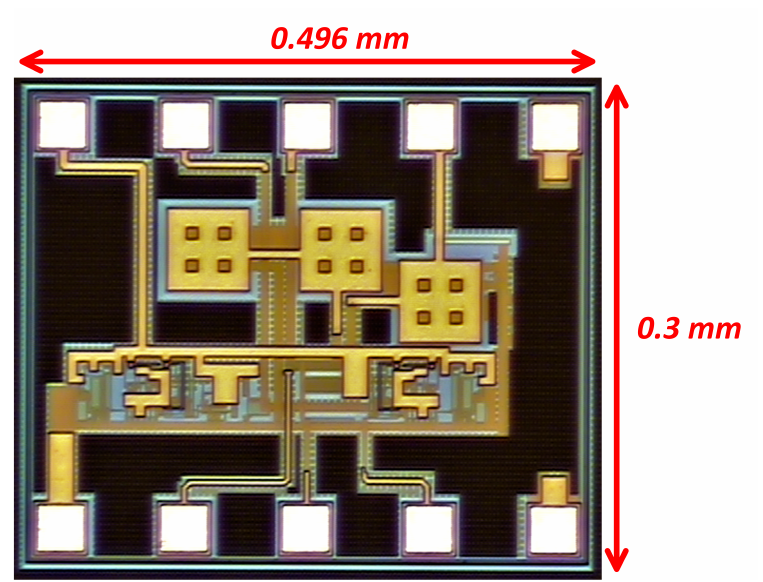
Figure 11. Micrograph of the proposed MVD-LDO.